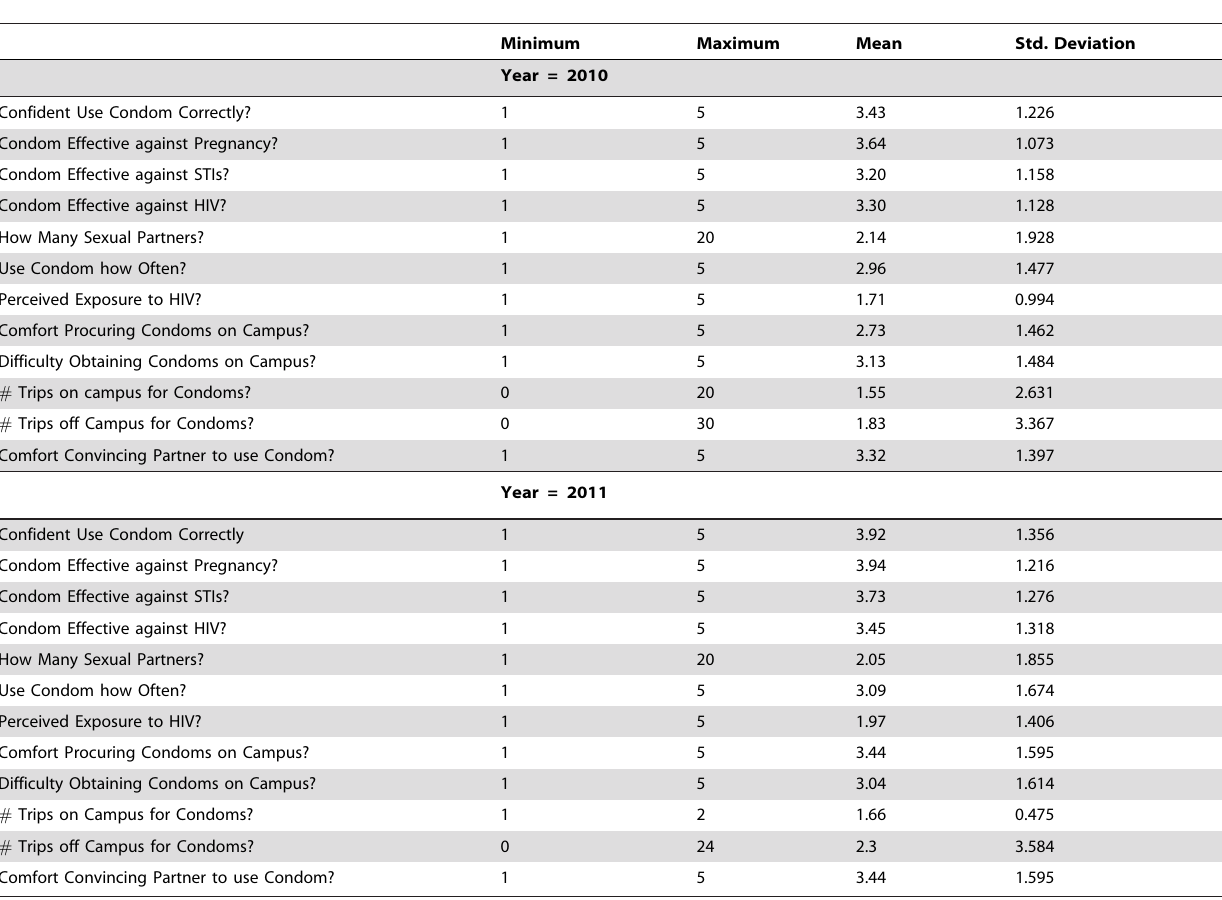
Table 3. Hawassa University student descriptive statistics for ordered and interval-level dependent variables, 2010 and